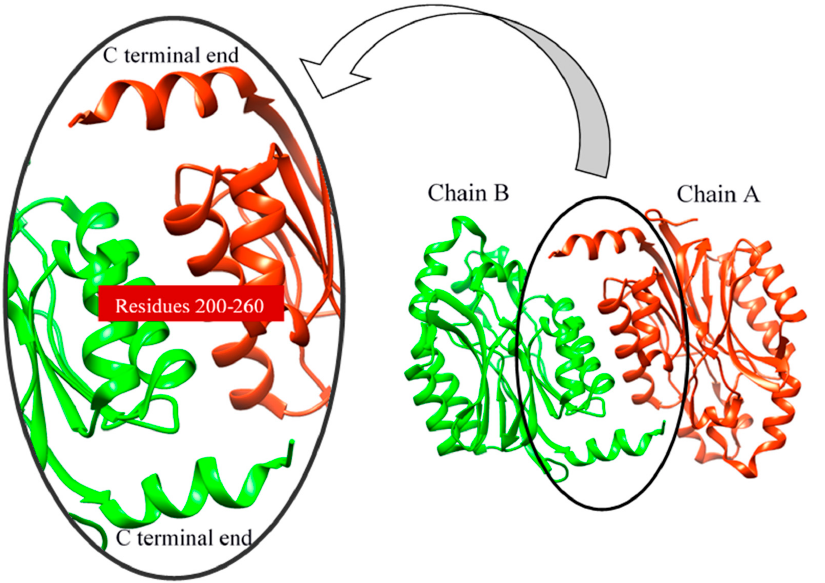
Figure 9. Interaction of two subunits (chain).